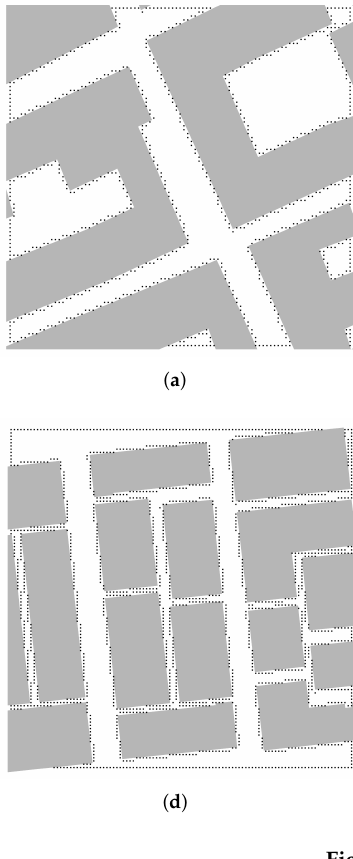
Figure 10. The simplified coverage regions of the five maps used in the experiments. ( a ) Coverage region: 90 × 86m 2 ; ( b ) Coverage region: 80 × 80m 2 ; ( c ) Coverage region: 90 × 85m 2 ; ( d ) Coverage region: 103 × 104m 2 ; ( e ) Coverage region: 99 × 95m 2